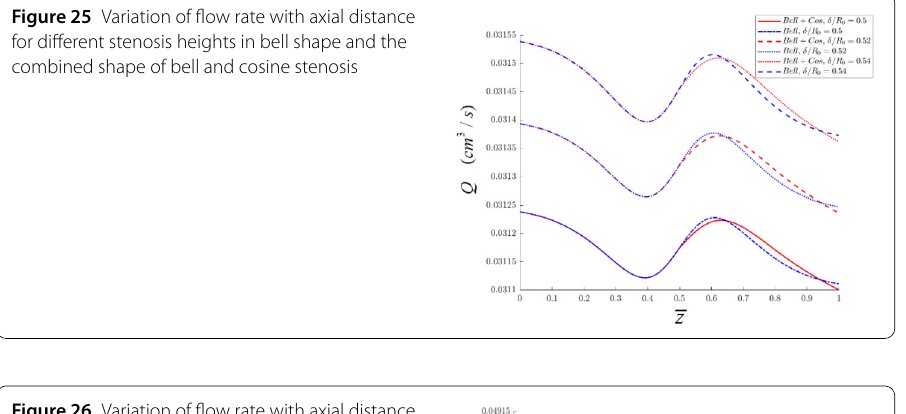
Figure 26 Variation of flow rate with axial distance for different stenosis heights in cosine shape and the combined shape of cosine and bell stenosis